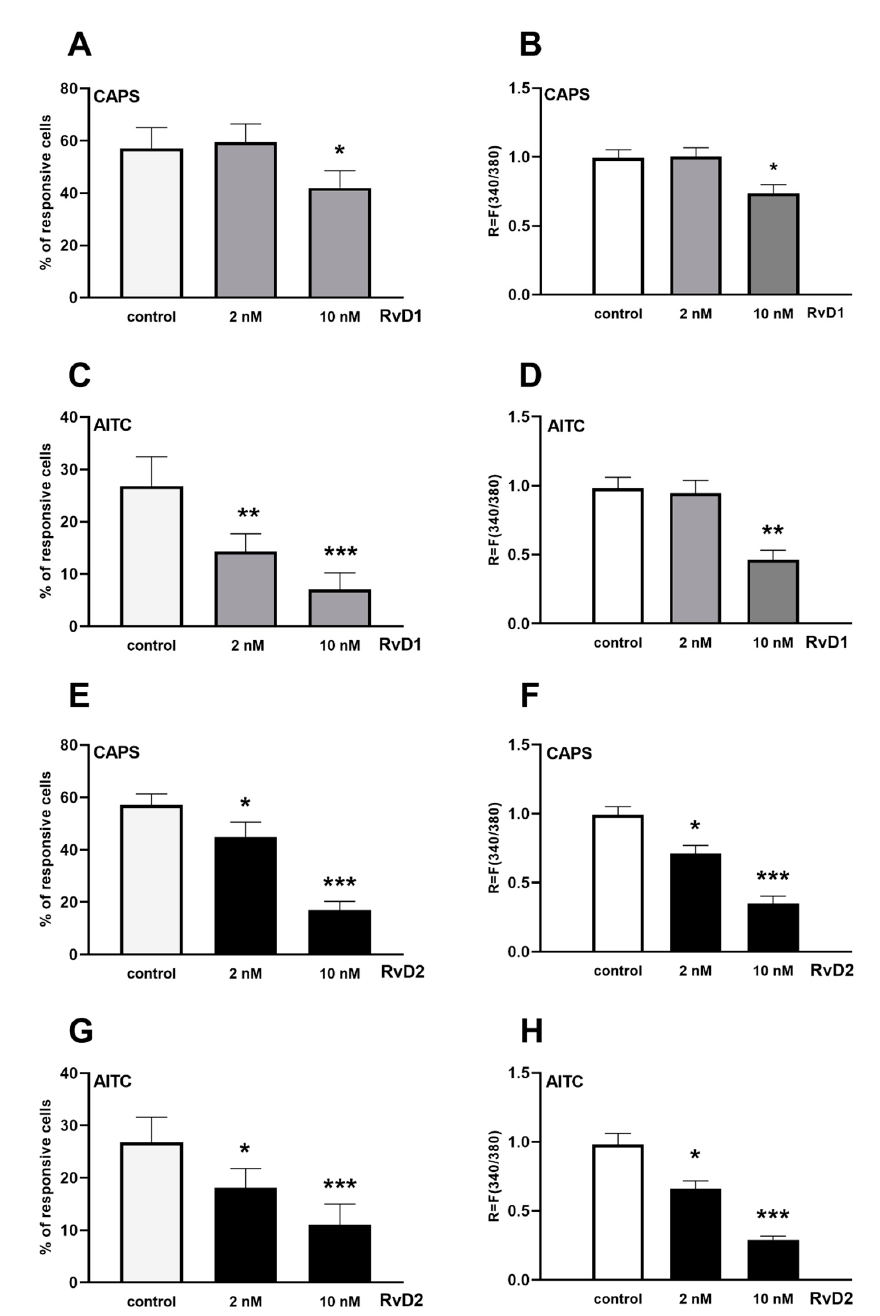
Figure 2. E ff ect of RvD1 and RvD2 on TRPV1 and TRPA1 receptor activation on cultured trigeminal ganglion sensory neurons. ( A , E ): The percentage of responsive cells to capsaicin (CAPS) is presented after ( A ): RvD1 (2 and 10 nM, n = 94–106 cells per group) and ( E ): RvD2 (2 and 10 nM, n = 102–108 cells per group) administration. ( B , F ): Change in the fluorescence ratio ( R = F 340 / F 380) after TRPV1 receptor activation in CAPS-sensitive cells is presented after ( B ): RvD1 and ( E ): RvD2 treatment. ( C , G ): The percentage of responsive cells to allyl-isothiocyanate (AITC) is presented after ( C ): RvD1 (2 and 10 nM, n = 84–170 cells per group) and ( G ): RvD2 (2 and 10 nM, n = 89–170 cells per group) administration. ( D , H ): Change in the fluorescence ratio ( R = F 340 / F 380) after TRPA1 receptor activation in AITC-sensitive cells is presented after ( D ): RvD1 and ( H ): RvD2 treatment. Ca 2 + -responses are presented in % of total number of examined neurons. (* p < 0.05, ** p < 0.01, *** p < 0.001 (control vs. treated, one-way ANOVA, Dunnett’s post hoc